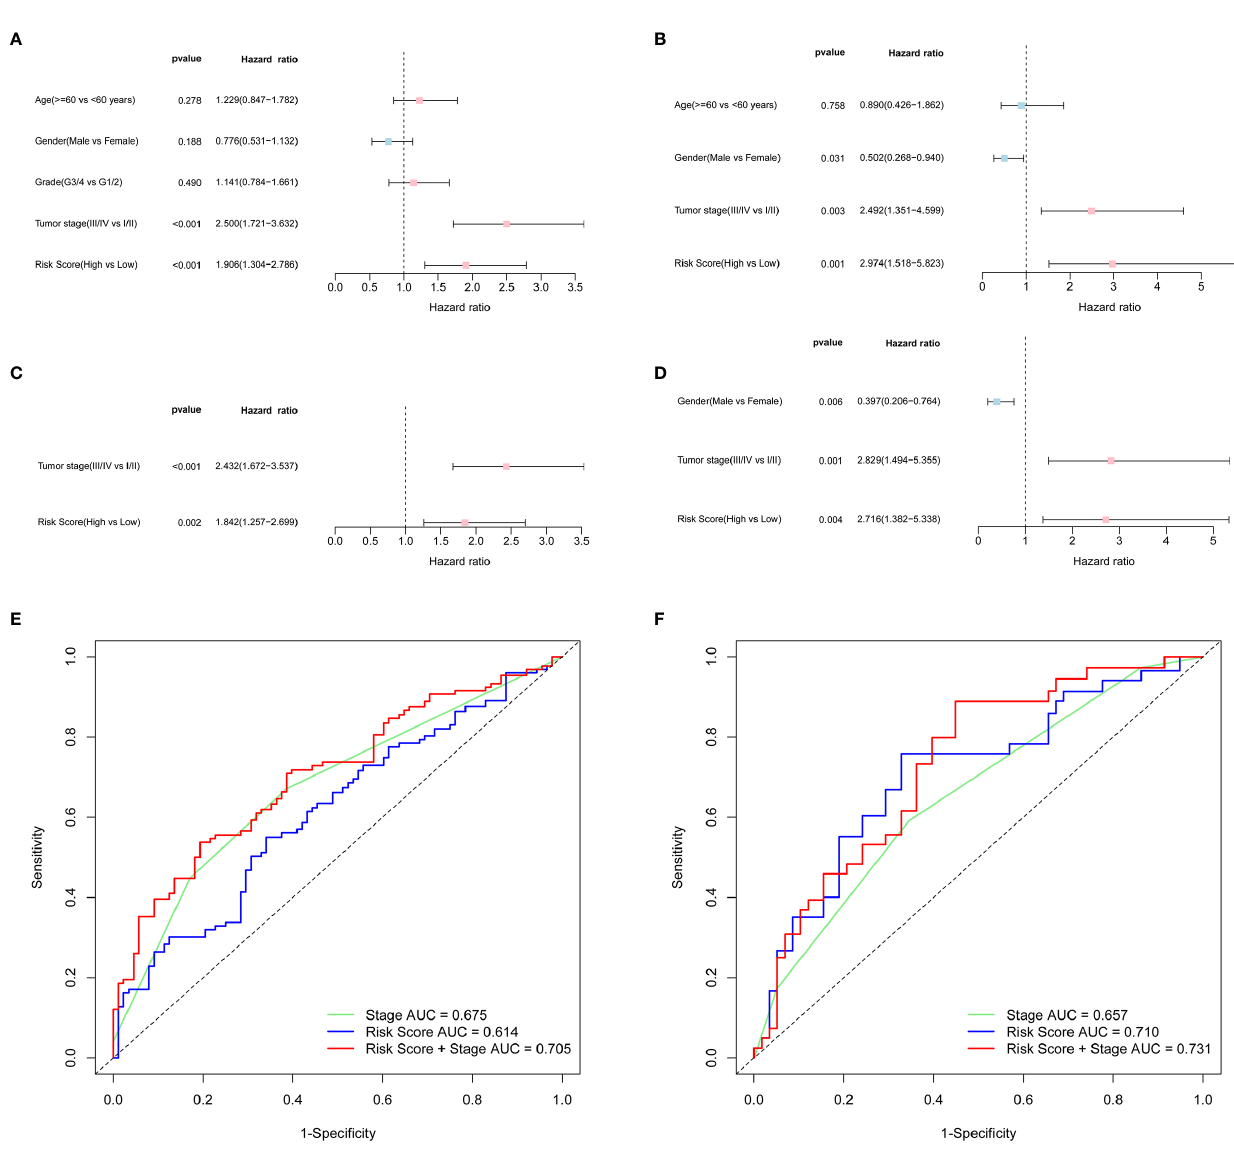
FIGURE 4 | OS-related factors were screened, and the prognostic accuracy of risk score and clinicopathological factors were compared. TCGA cohort (A, C, E) , ICGC cohort (B, D, F) . (A, B) OS-related factors were screened by Univariate Cox regression analyses. (C, D) OS-related factors were screened by Multivariate Cox regression analysis. (E, F) Time-dependent ROC curve was used to compare the prognostic accuracy of risk score, tumor stage, and the combination of risk score and tumor stage in